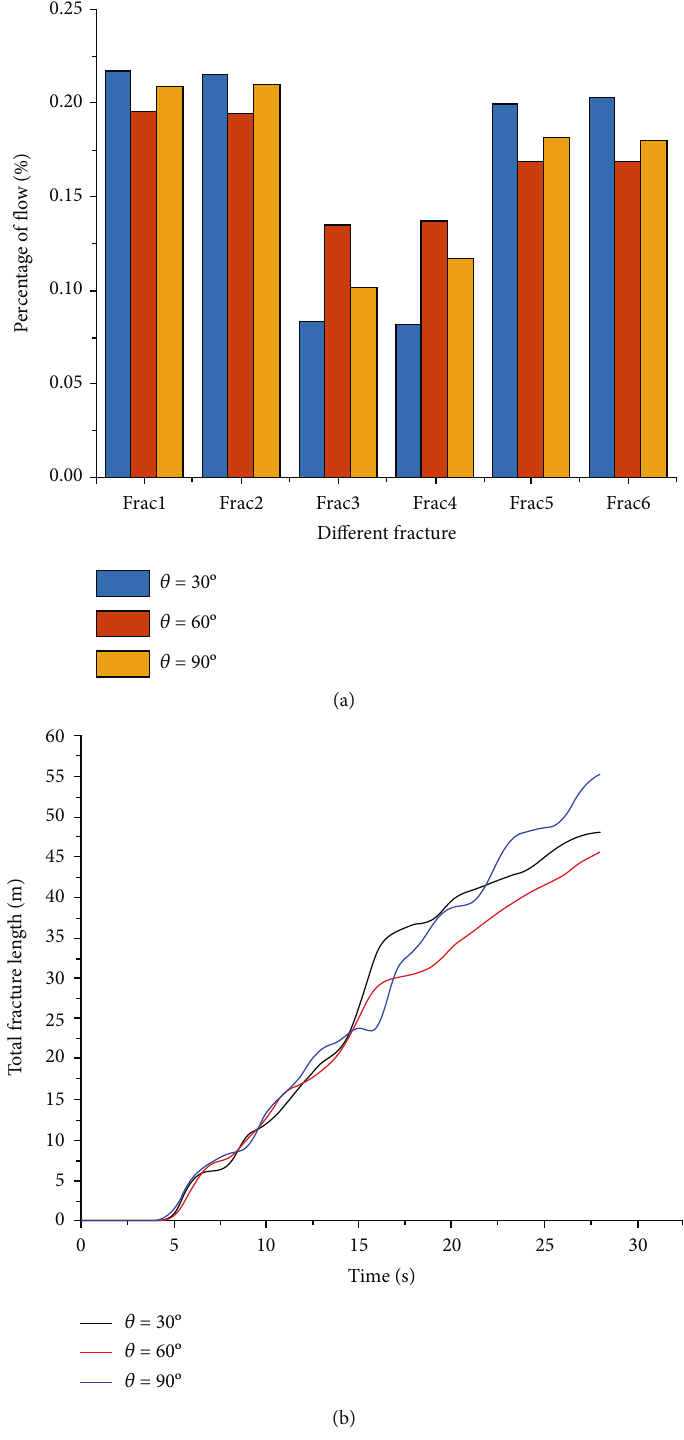
Figure 8: (a) Fluid distribution in fractures for varying orientations of natural fractures. (b) Hydraulic fracture length for varying orientations of natural